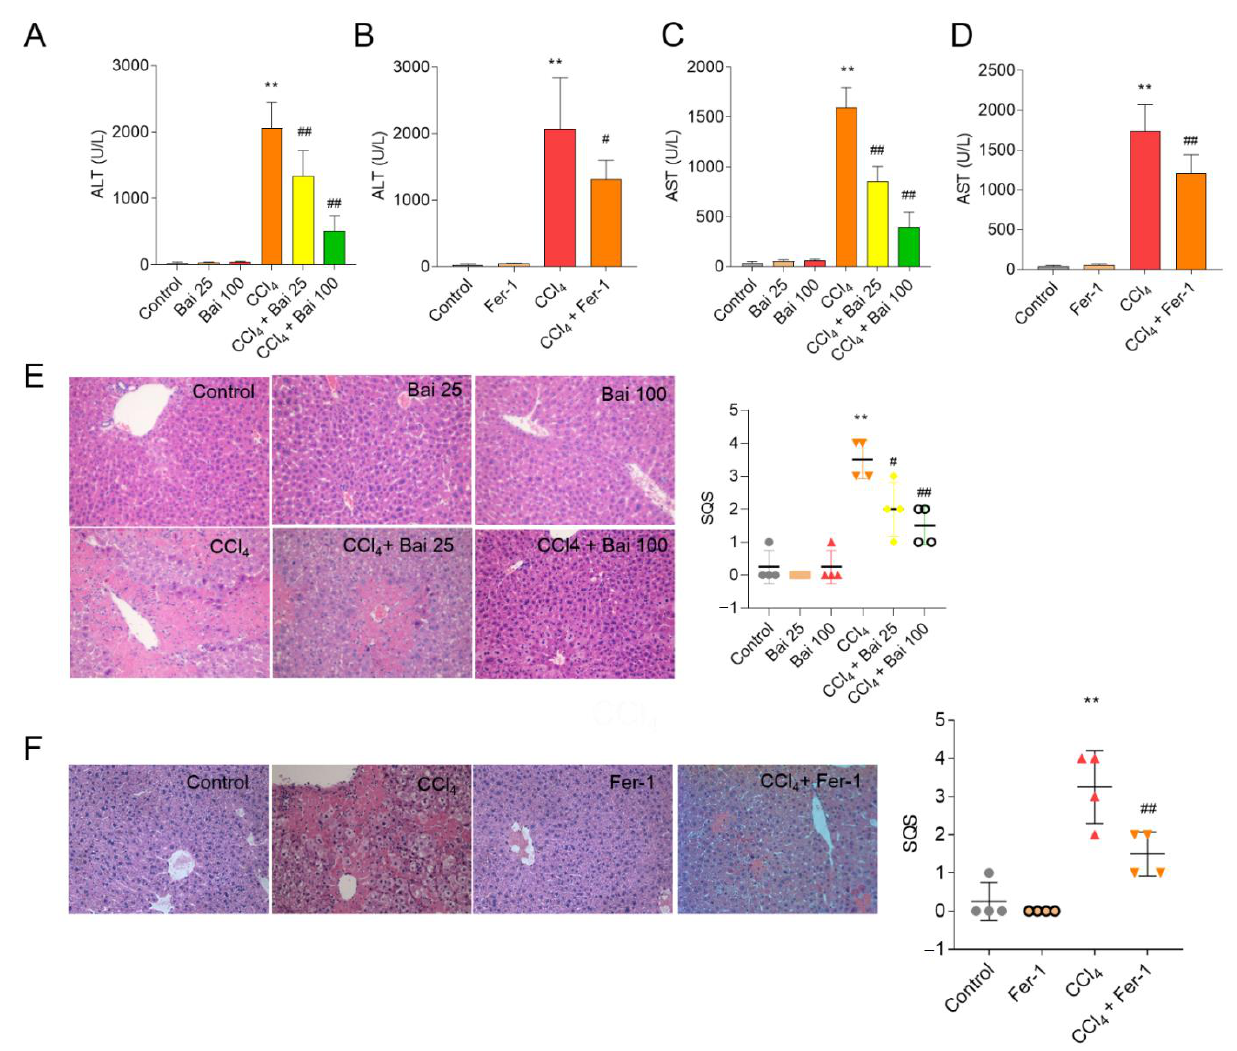
Figure 3. Effects of baicalein and Fer-1 supplementation on CCl 4 -induced liver dysfunction and histopathology. Levels of serum ( A , B ) ALT and ( C , D ) AST ( n = 6). ( E , F ) Representative histopathological images of hematoxylin and eosin (H&E) stained liver sections and their semi-quantitative scoring (SQS ( n = 4)). Magnification, × 20. All results are presented as mean ± SD. ** p < 0.01, compared to the untreated control group, respectively; # p < 0.05 or ## p < 0.01 compared to the CCl 4 only group. Bai, baicalein. Fer-1, ferrostatin-1.